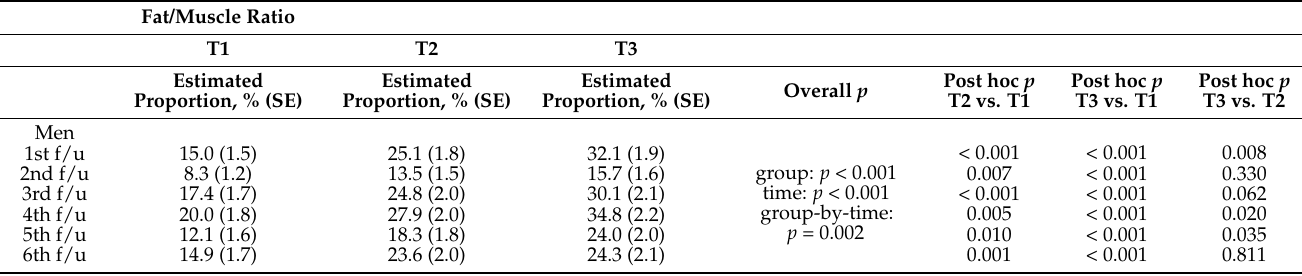
Table 3. Generalized estimating equation models predicting the effects of time on the proportions of non-achievement of LDL cholesterol targets according to the sex-specific tertiles of fat-to-muscle ratio. Fat/Muscle